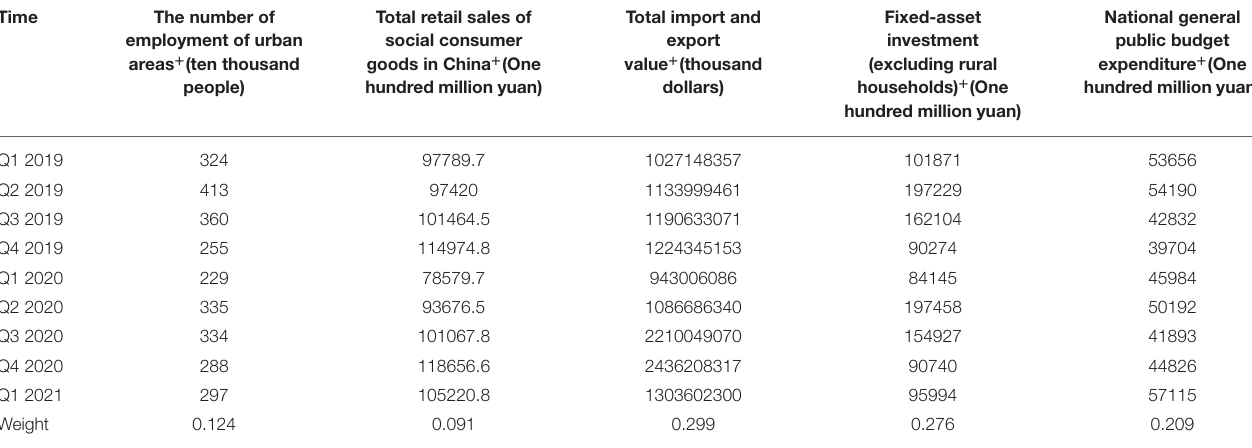
TABLE 1 | 2019 Q1–2020 Q1 economic data tables.